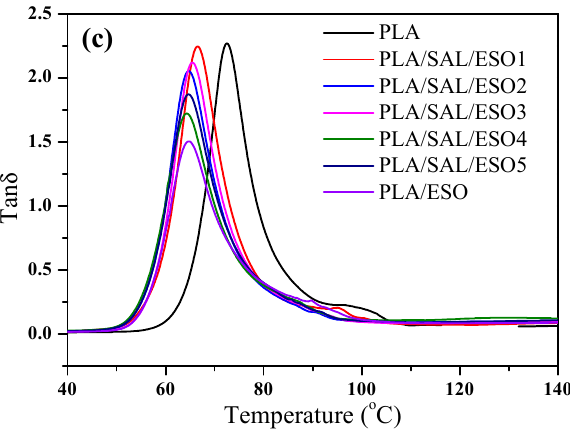
Figure 8. Dynamic mechanical properties of PLA, PLA / ESO, and PLA / SAL / ESO composites showing: ( a ) storage modulus ( E ´), ( b ) loss modulus ( E ´´), and ( c ) tan δ .